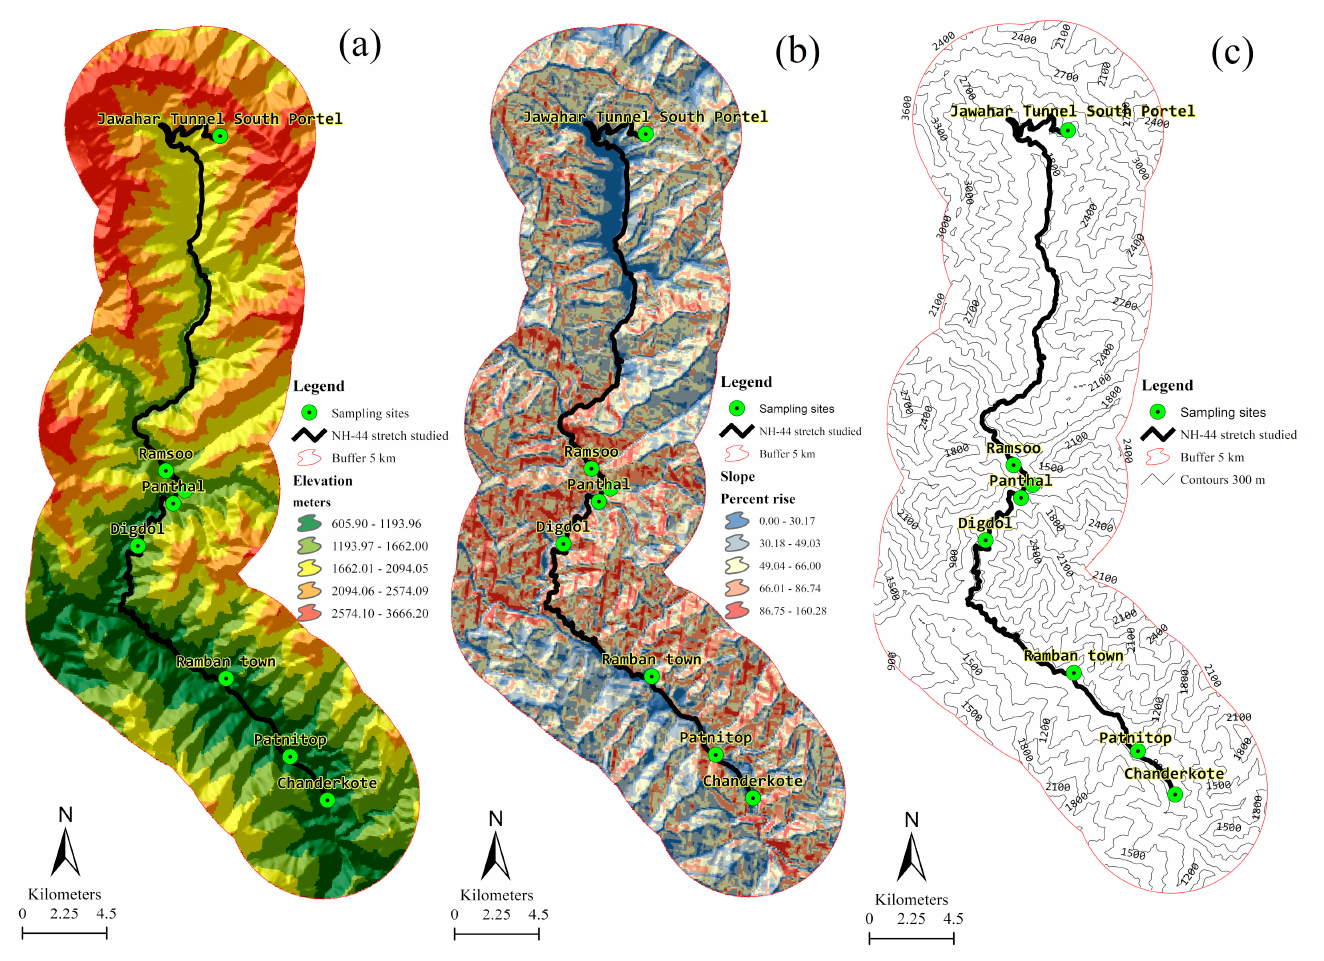
Figure 13. ( a ) Elevation map, ( b ) slope map, and ( c ) contour map of the study area. Various studies in the Himalayan regions have carried out landslide assessments.